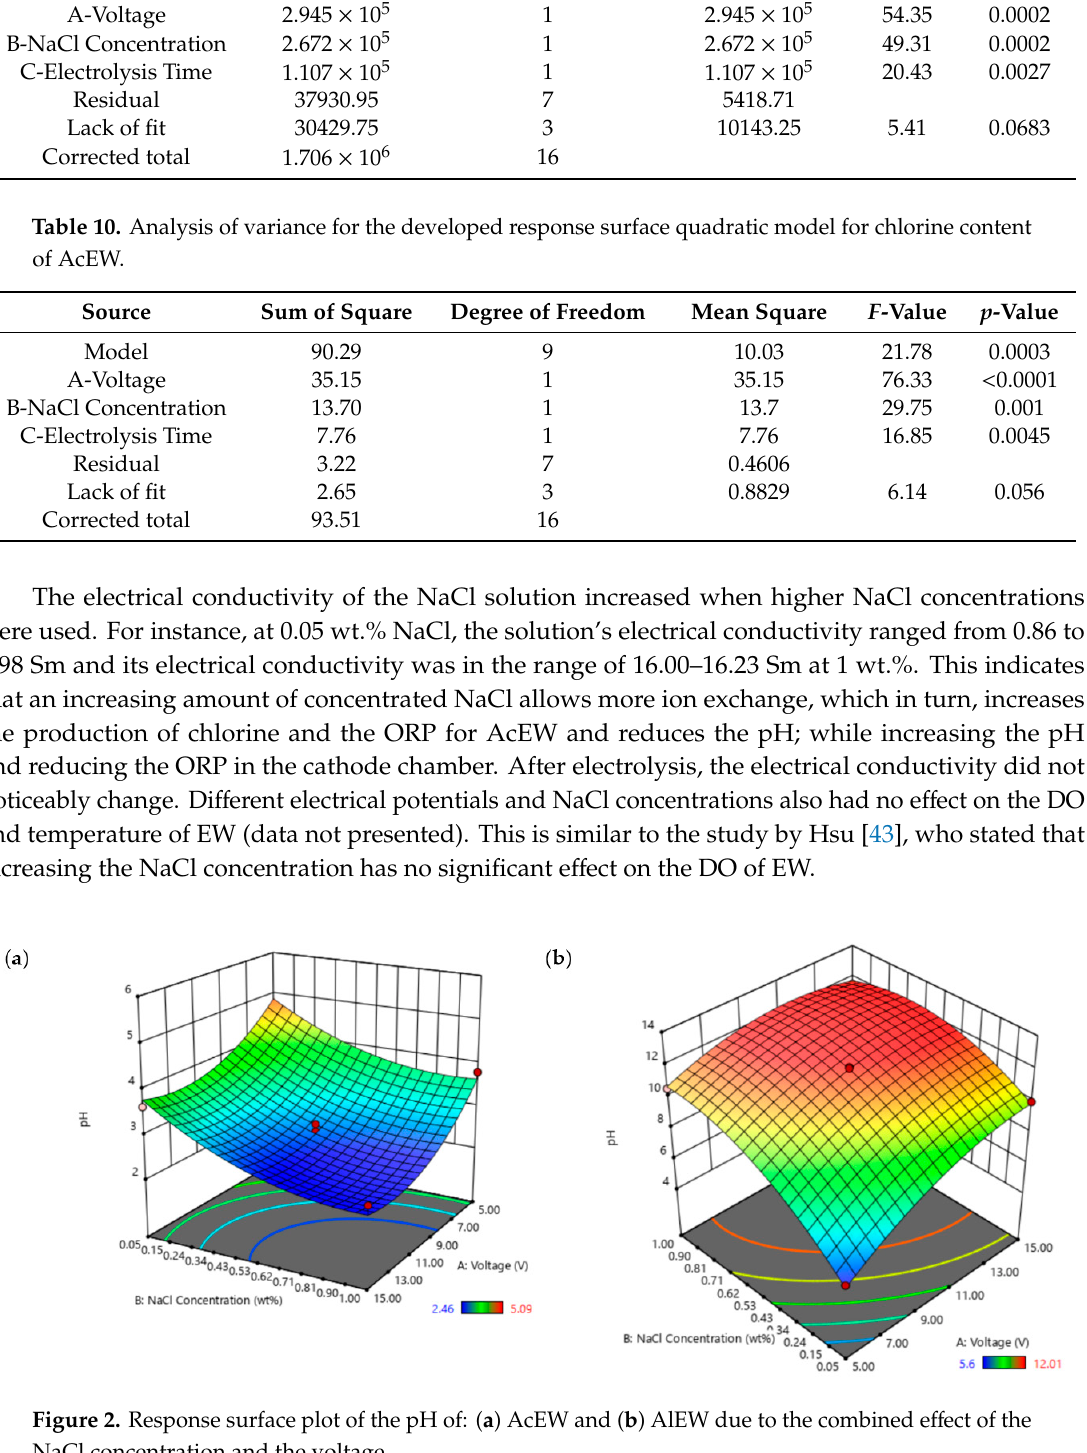
Figure 3. Response surface plot of the ORP of: ( a ) AcEW and ( b ) AlEW due to the combined effect of the NaCl concentration and the voltage. Figure 4. Response surface plot of the chlorine content of AcEW due to the combined effect of the NaCl concentration and the voltage.